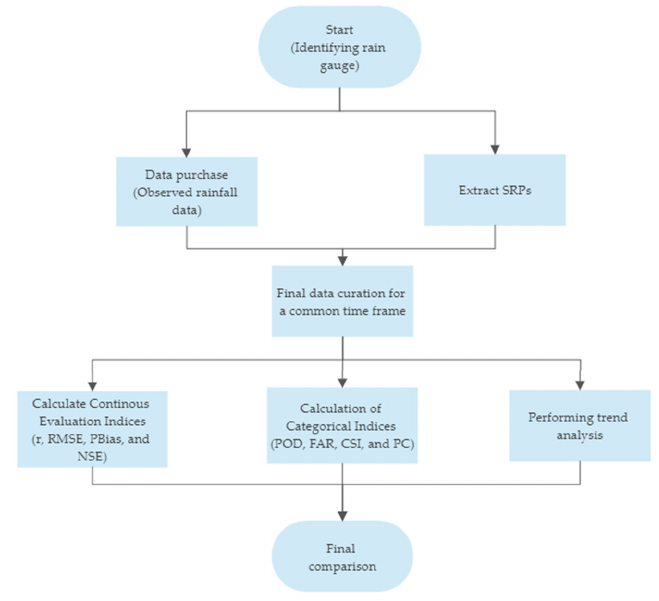
Figure 5. Flowchart of the